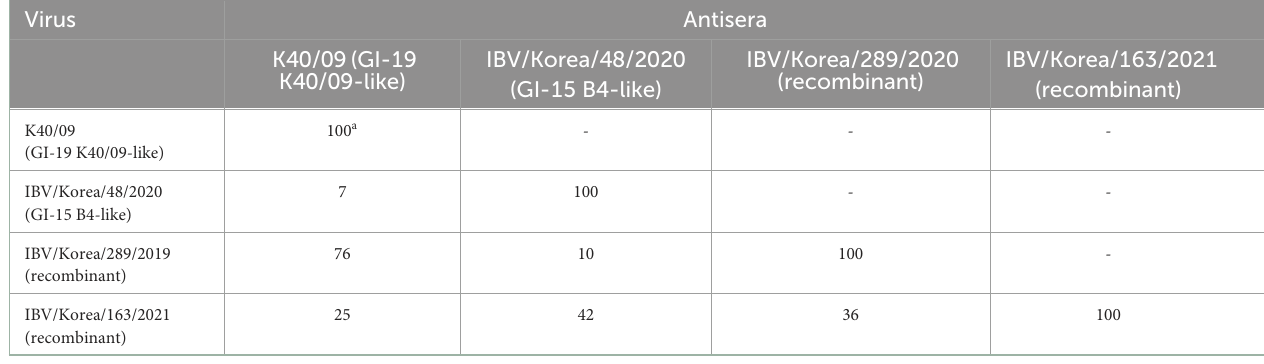
TABLE 3 Antigenic relatedness (R-value) between the IBVs used in this study.